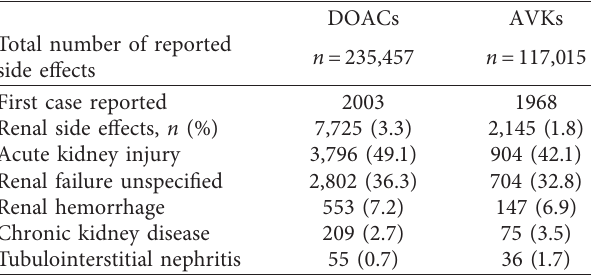
Results are presented as number of subjects (valid percentage). Table 4: Number and type of renal side effects for DOACs and antivitamin K retrieved (until 27 th April 2019) from VigiAccess database of the WHO Program for International Drug Monitoring (available at http://www.vigiaccess.org/).